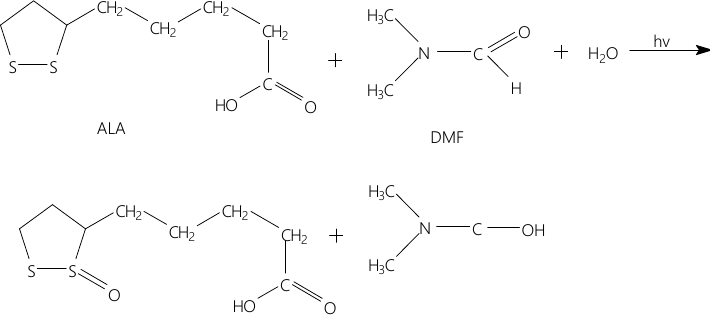
Scheme 1. The photochemical reaction of ALA in the presence of DMF and H 2 O.